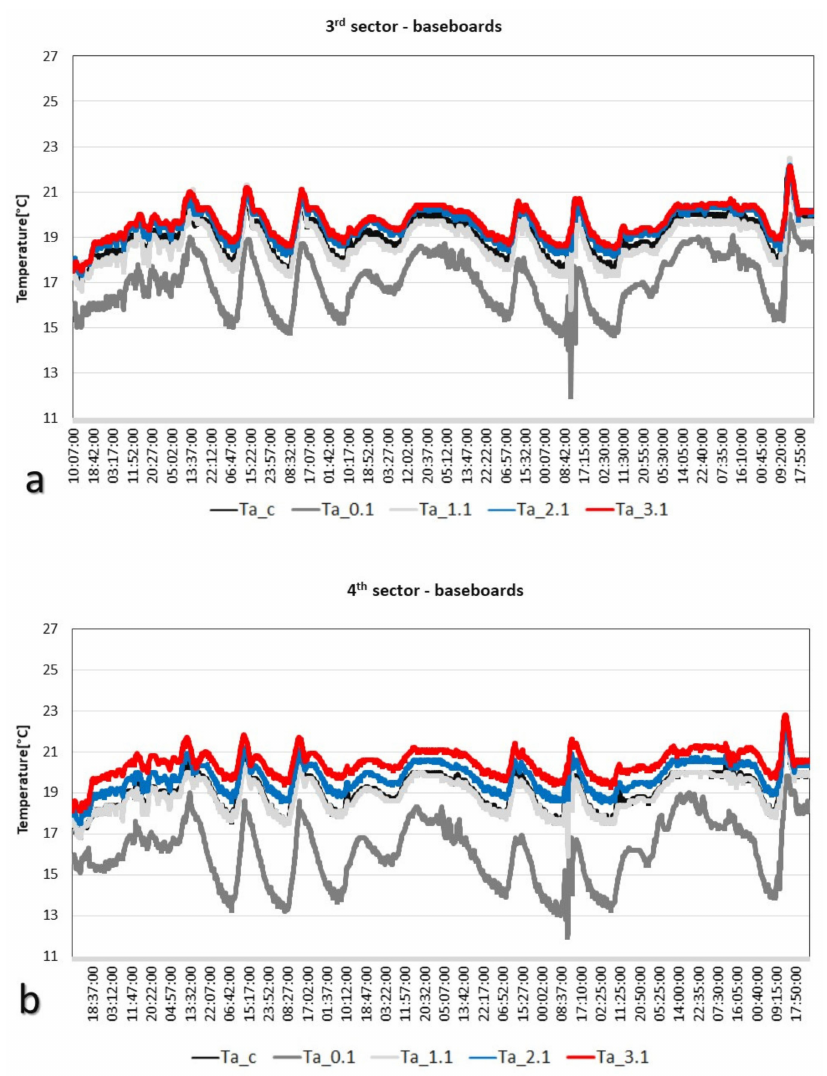
Figure 8. Air temperature at different heights with baseboards: ( a ) 3rd sector, ( b ) 4th